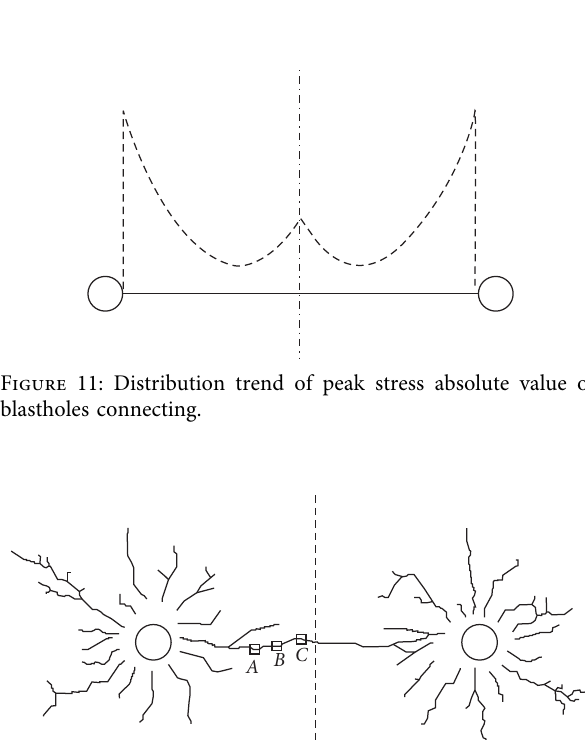
Figure 10: Curve of maximum shear stress-time on selected elements.